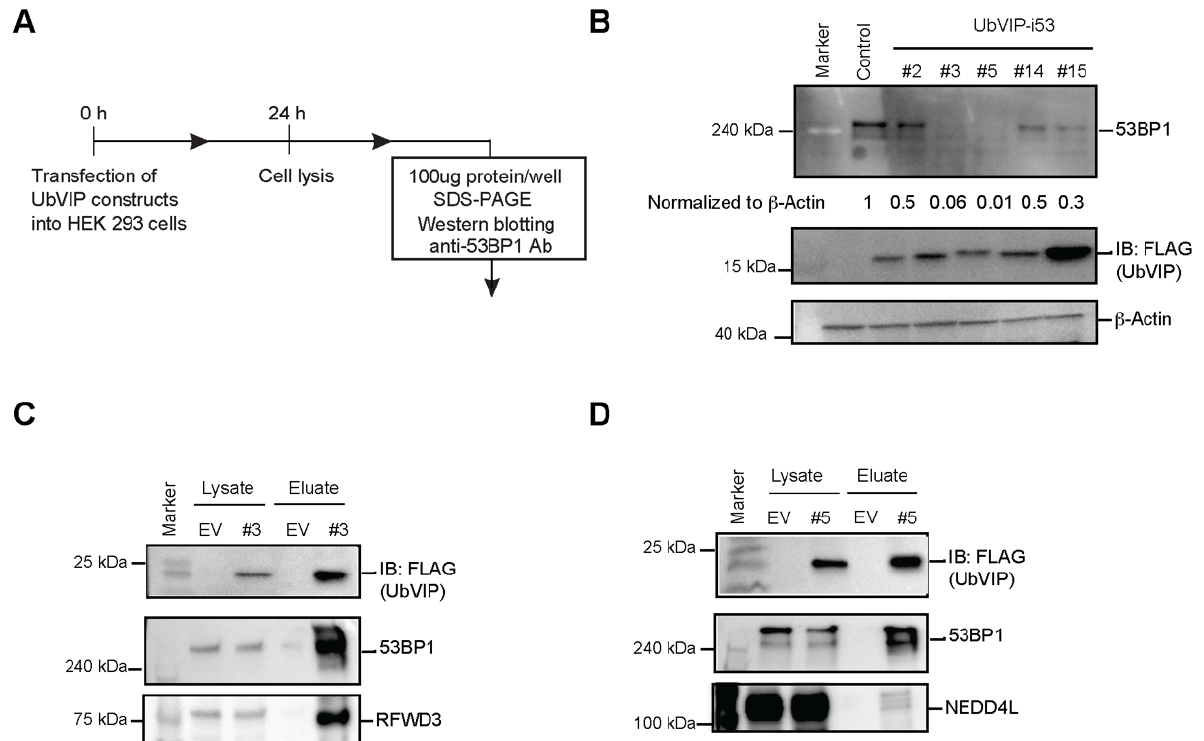
Figure 3. Two UbVIPs recruited cellular E3 ligases to induce 53BP1 degradation. ( A ) Experimental outline for determining 53BP1 protein expression in mammalian cells. HEK 293 cells were trans- fected with the UbVIP constructs and cells lysed after 24 h and whole cell lysates were subjected to SDS-PAGE and immunoblotting using an anti-53BP1 antibody. ( B ) Western blot analysis of 53BP1 expressed in HEK 293 cells compared to untransfected control, presence of UbVIP was confirmed by blotting for FLAG. β -Actin was used as a loading control. The UbVIP-i53#3 and #5 corresponding to UbV RF.9 -8aa-i53 and UbV NL.1 -8aa-i53 respectively, caused a reduction in 53BP1 levels when compared to UbVIP with the same targets but different orientation. 53BP1 protein abundance was measured using ImageJ software and normalized to β -Actin. Values indicated are relative to the untransfected control. ( C , D ) UbVIP-i53#3 and #5 interact with 53BP1 and corresponding E3 ligases (RFWD3 and NEDD4L). Immunoprecipitation (IP) of Flag-tagged proteins from extracts prepared from HeLa cells transfected with vectors expressing UbVIP-i53 #3 and UbVIP-i53 #5 or the empty vector control. Proteins were separated by SDS-PAGE and immunoblotted (IB) for FLAG, 53BP1, RFWD3 in ( C ) and NEDD4L in ( D ).